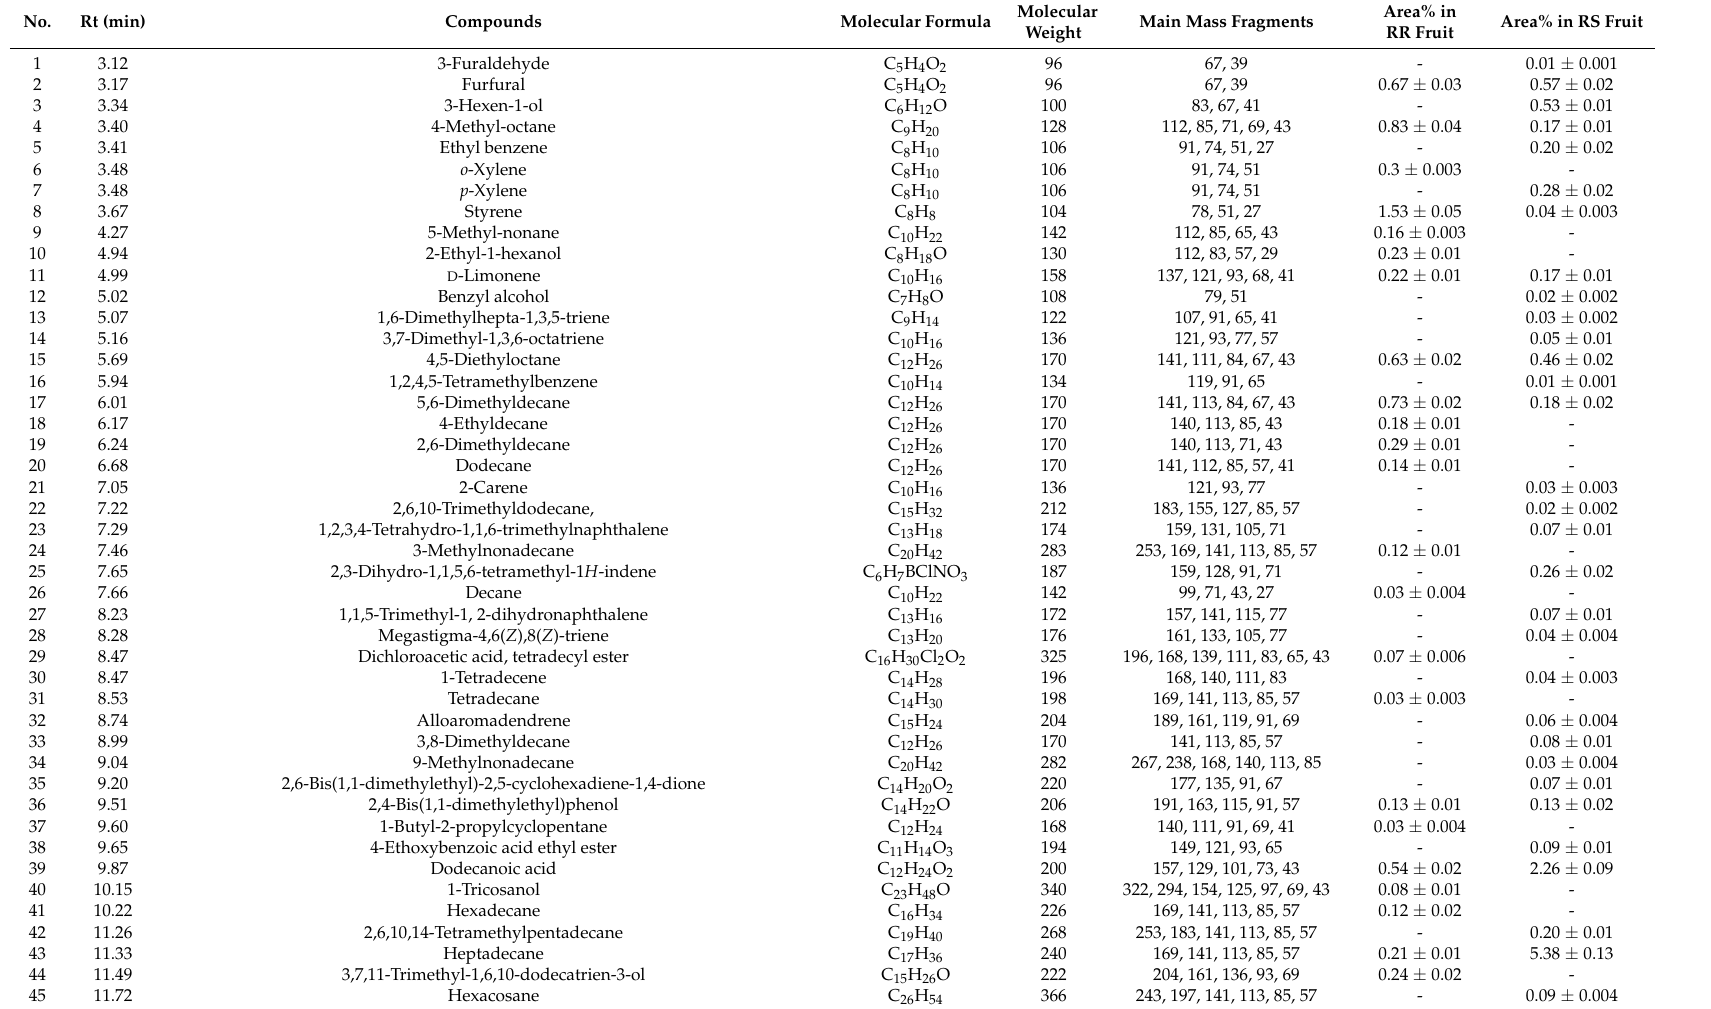
Table 1. Volatile compounds identified in R. roxburghii and R. sterilis fruits by GC-MS ( n =